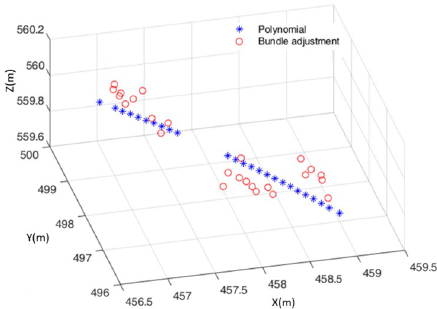
Figure 7. Twenty-five band positions of a hypercube after estimation by both